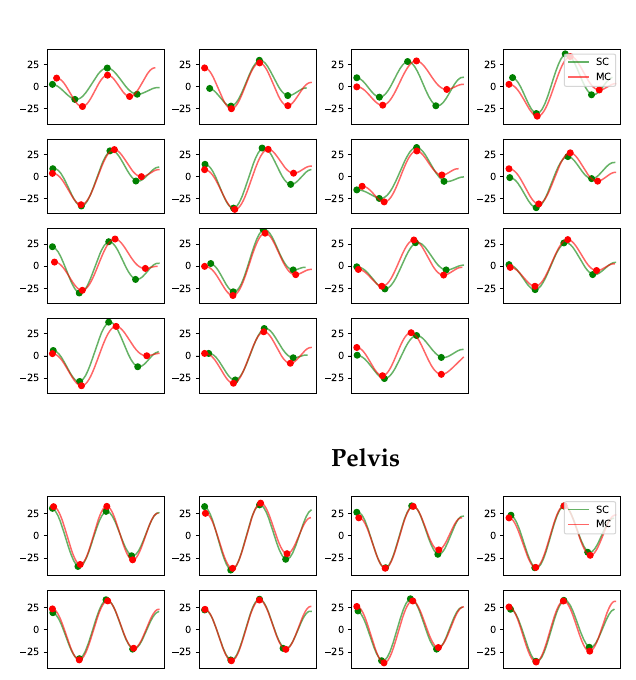
Figure A24. Vertical displacement signals per stride for the head and pelvis for horse 25. Each subplot contains the matched stride segments for the single-camera markerless system (SC) in green and the multi-camera marker-based system (MC) in red). The y-axis shows the vertical displacement in millimeters. The four dots on each curve indicate the positions of the two peaks and two valleys extracted using the approach in Section